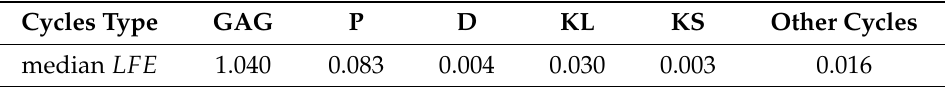
Table 4. Contribution of different types of cycles to Landing Fatigue Equivalent ( LFE